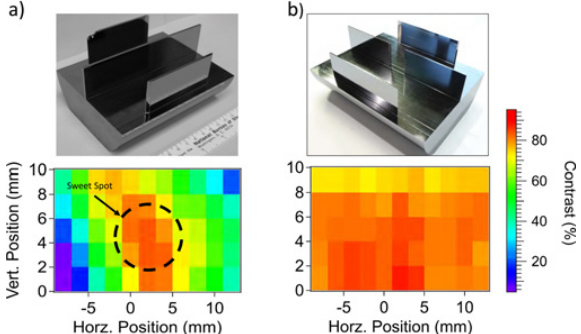
Figure 8. A comparison of “Zeus” which has been the most prolific neutron interferometer at NIST with “Hera” post heat treatment. One can see that the contrast of “Hera” is now both high and uniform across its front surface. The crystal “Zeus” exhibits typical behavior where contrast is highest only for a limited area or sweet